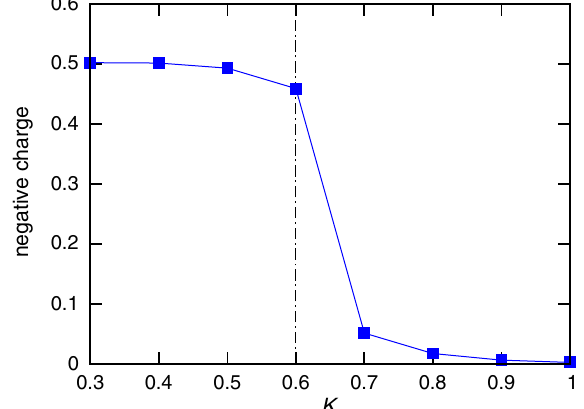
FIG. 10. A demonstration of how the Witten effect can be used to detect phase transitions. The plot shows the amount of charge enclosed by a sphere with w ¼ 1 , while changing K but keeping all other parameters the same as in Fig. 8. We can compare to Fig. 7, and see that at K ¼ 0 . 6 , when the system transitions from the topological phase to the Coulomb phase, the 1 = 2 quantization of the enclosed charge abruptly